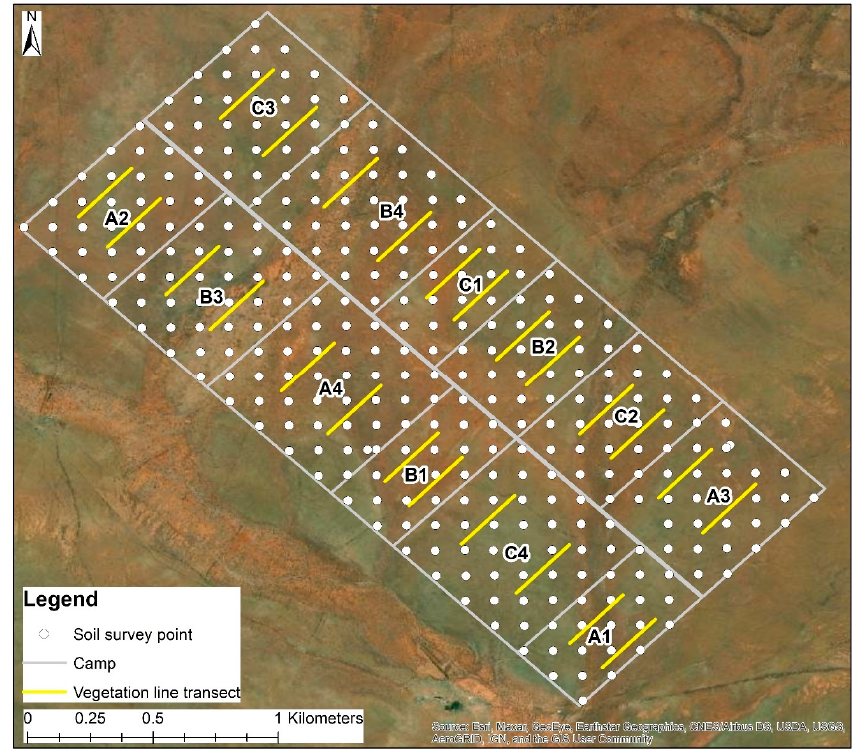
Figure 2. The stocking density trial layout with 12 camps, soil survey points (black filled circles) and vegetation line transects (yellow lines). High stocking density = camps assigned the numbers A1, B1 and C1; recommended stocking density = A2, B2 and C2; low stocking density = A3, B3 and C3; and very low stocking density = A4, B4 and C4.